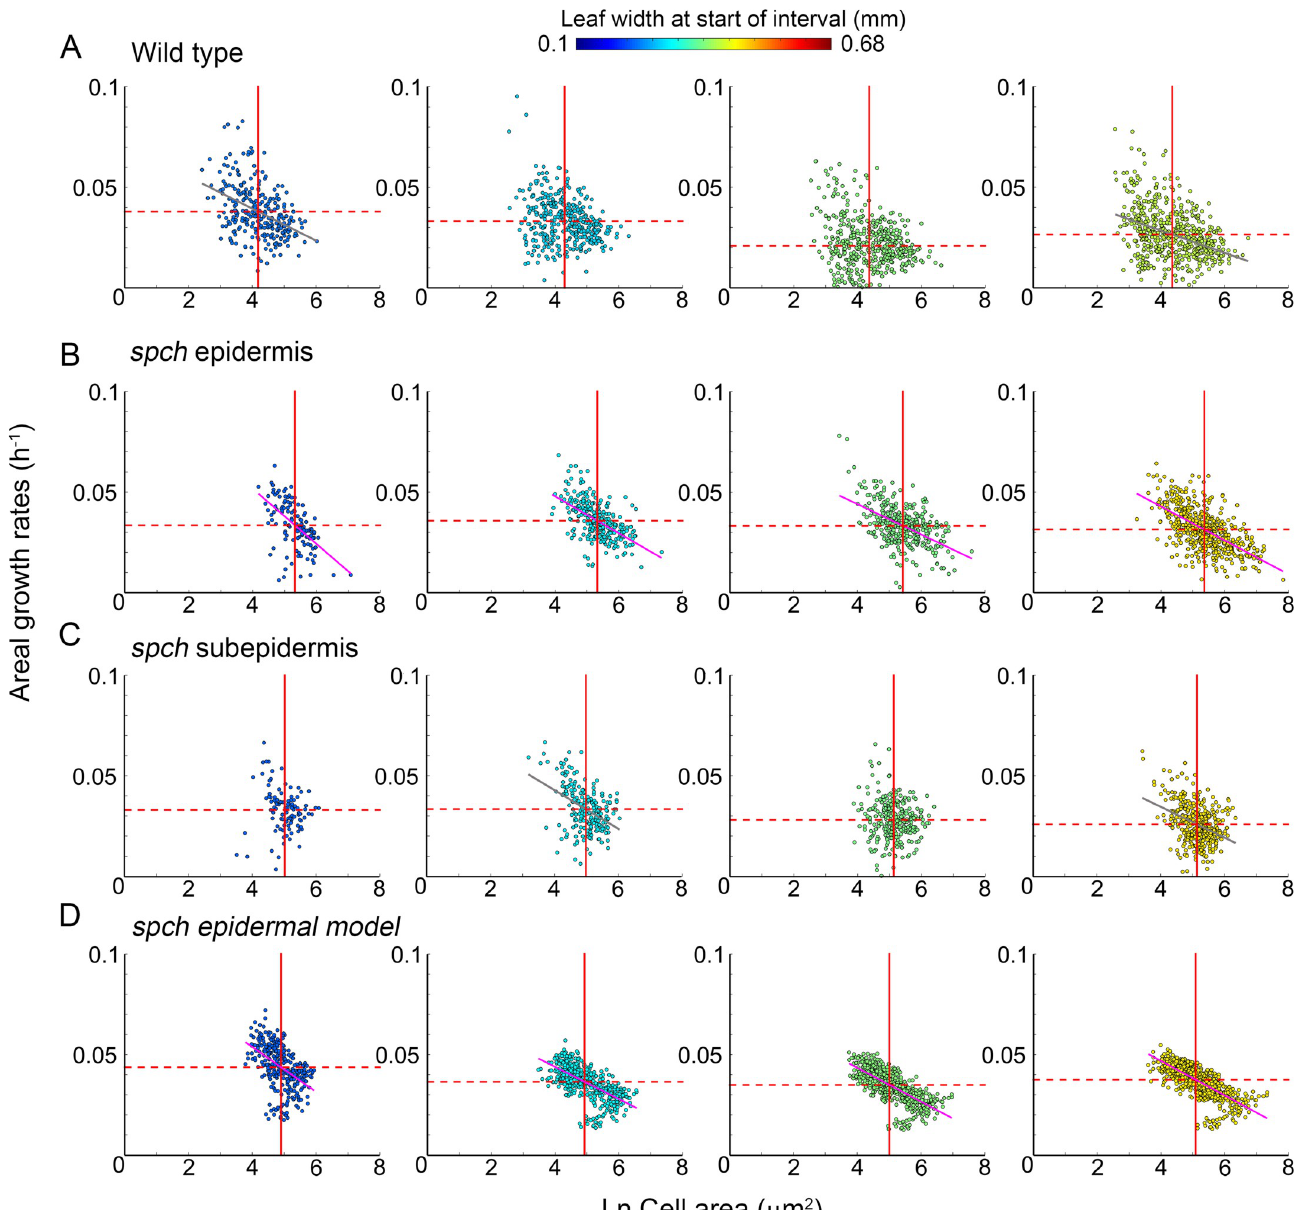
Fig 4. Correlations between growth rates and cell size. Areal cell growth rates against log cell area for time intervals at different developmental stages. Data points are colour coded according to leaf width at the start of the interval (colour scale is shown at the top). Solid red lines indicate mean cell areas ( μ a ) and dashed red lines indicate mean growth rate ( μ k ), with ± ranges indicating 1.96 × standard error of mean. Lines fitted for R 2 > 0.2 are shown in magenta; those with R 2 < 0.2 and > 0.1 are shown in grey ( p -values are all less than 5.1 × 10 − 6 for line fits). ( A ) Wild type (from dataset shown in Fig 7B–7D, time intervals: 12–25 h, 25–37 h, 37–47 h, 47–57 h). From left to right, μ a = {4.2 ± 0.08, 4.3 ± 0.07, 4.4 ± 0.07, 4.4 ± 0.07}, μ k = {0.038 ± 0.001, 0.033 ± 0.001, 0.021 ± 0.001, 0.026 ± 0.001}, gradient m = { − 0.008, − 0.004, − 0.002, − 0.006}, and R 2 = {0.18, − , − ,0.14}.( B ) spch epidermis (from dataset shown in Fig 1, time intervals: 14–24 h, 35–47 h, 47–58 h, 58–74 h), μ a = {5.3 ± 0.08, 5.3 ± 0.06, 5.4 ± 0.06, 5.4 ± 0.06}, μ k = {0.033 ± 0.001, 0.036 ± 0.001, 0.033 ± 9 × 10 − 4 , 0.031 ± 8 × 10 − 4 }, m = { − 0.014, − 0.009, − 0.008, − 0.008}, and R 2 = {0.31,0.31,0.27,0.38}. ( C ) spch subepidermis (from dataset shown in Fig 6, time intervals: 14–24 h, 35–47 h, 47–58 h, 58–74 h), μ a = {5.0 ± 0.09, 5.0 ± 0.06, 5.1 ± 0.05, 5.1 ± 0.05}, μ k = {0.033 ± 0.002, 0.033 ± 0.001, 0.028 ± 0.001, 0.026 ± 9 × 10 − 4 }, m = { − 0.003, − 0.010, − 0.002, − 0.008}, and R 2 = { − , 0.19, − , 0.15}. ( D ) spch epidermal model output at stages corresponding to leaf widths in (B), μ a = {4.9 ± 0.05, 4.9 ± 0.05, 5.0 ± 0.04, 5.0 ± 0.04}, μ k = {0.045 ± 0.001, 0.037 ± 5 × 10 − 4 , 0.035 ± 0.004, 0.038 ± 1 × 10 − 4 }, m = { − 0.012, − 0.008, − 0.008, − 0.009}, R 2 = {0.33,0.42,0.54,0.59}. Source data are available from https://figshare.com/s/ b14c8e6cb1fc5135dd87. Ln, natural logarithm; spch , speechless